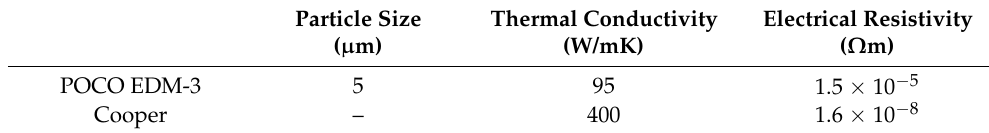
Figure 1. Scheme of research set-up: measurement circuit of voltage and current. Table 2. Physical properties of electrodes [48].